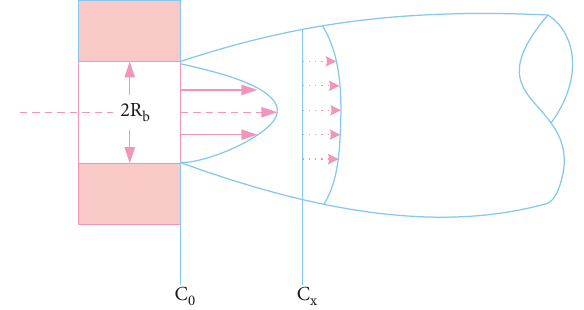
Figure 5: Schematic diagram of jet flowing out of